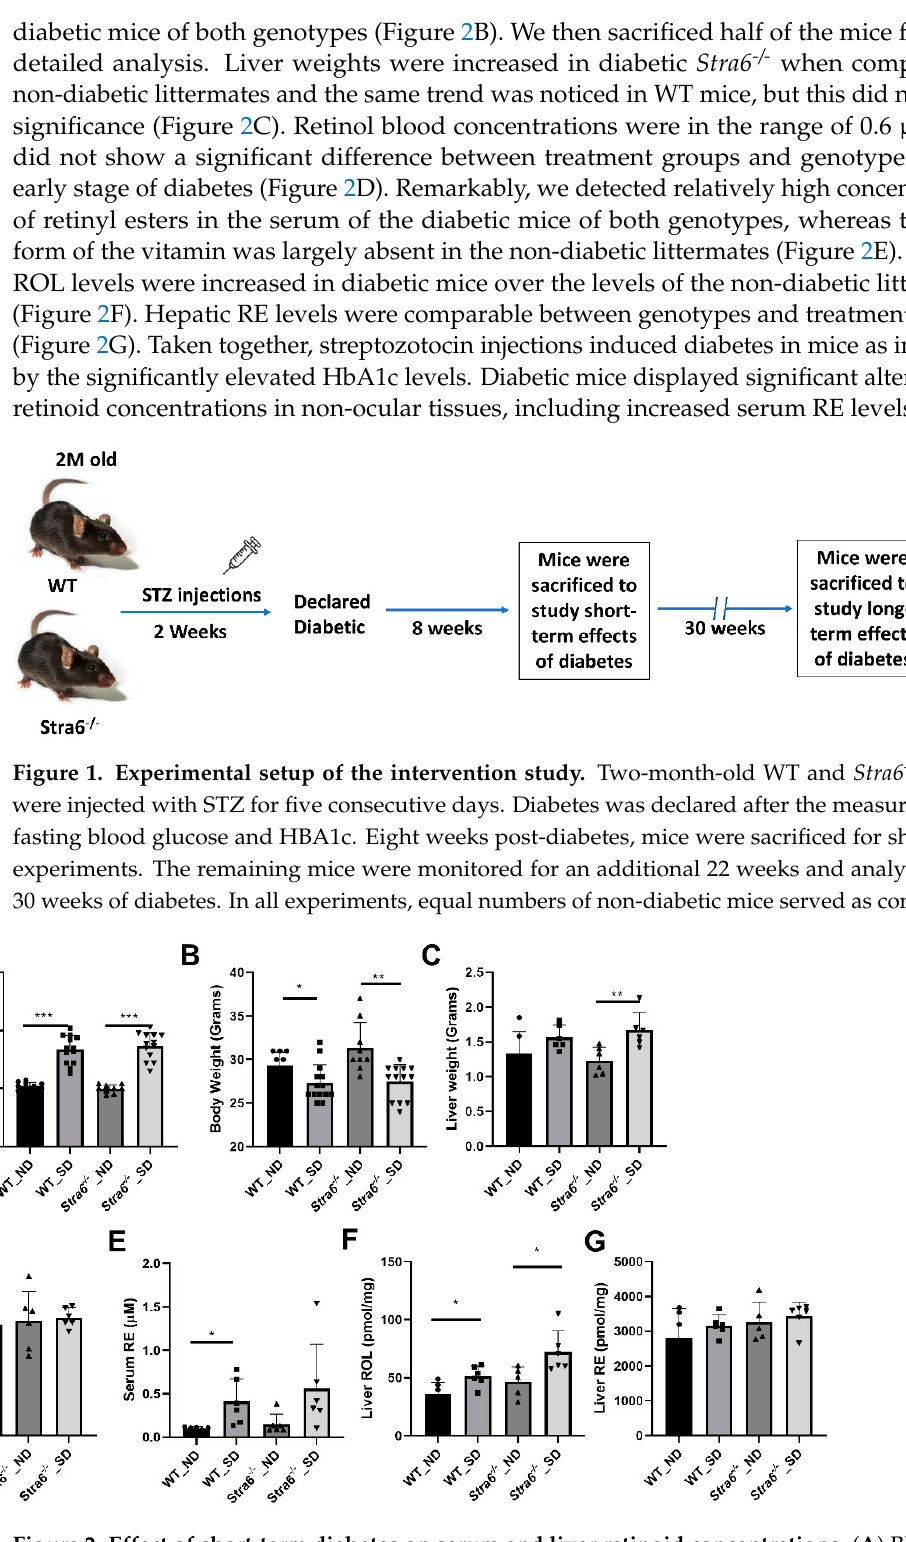
Figure 2. Effect of short-term diabetes on serum and liver retinoid concentrations . ( A ) Blood concentrations of hemoglobin A1c. ( B ) Bodyweight. ( C ) Liver weight. ( D ) Serum retinol concentrations. ( E ) Serum retinyl ester concentrations. ( F ) Hepatic retinol concentrations. ( G ) Hepatic retinyl ester concentrations in non-diabetic (ND) and diabetic (SD) WT and Stra6 -/--/- mice. The values represent means ± SD of data from at least six animals per genotype and condition. The statistical analysis was performed using a two-tailed student’s t -test. * p ≤ 0.05, ** p ≤ 0.01, *** p ≤ 0.001.